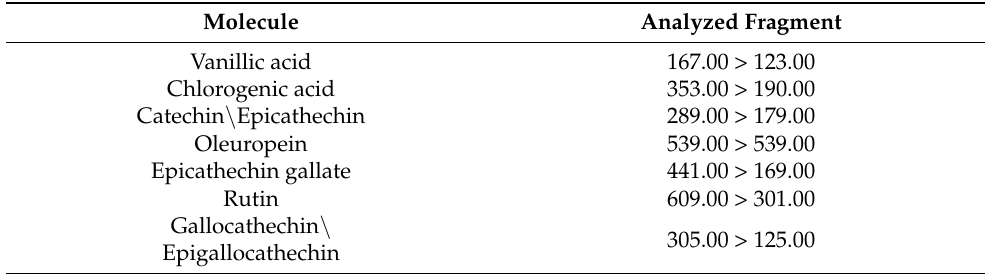
Table 1. The detected molecules in the polyphenol fraction of Coriandrum sativum seeds (PCS) according to the LC/MS-MS